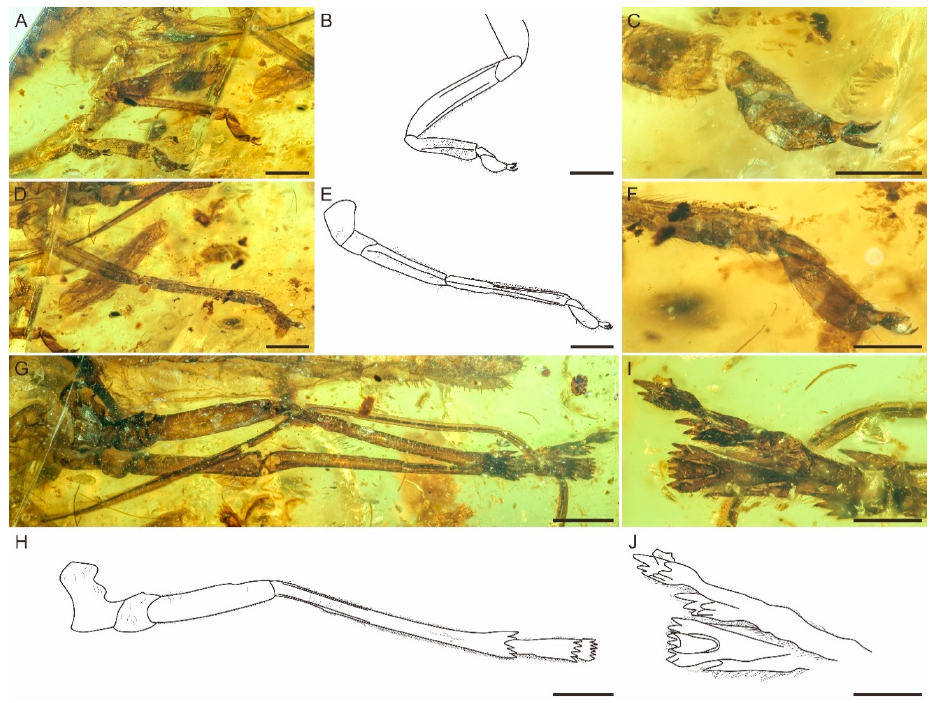
Figure 3. Detailed photographs and line drawing of legs of Spinonympha shcherbakovi gen. et sp. nov. ( A ) Left foreleg in left lateral view. ( B ) Line drawing of left foreleg in left lateral view. ( C ) Protarsus. ( D ) Left midleg in left lateral view. ( E ) Line drawing of left midleg in left lateral view. ( F ) Mesotarsus. ( G ) Hindleg in left lateral view. ( H ) Line drawing of left hindleg in left lateral view. ( I ) Mesotarsus. ( J ) Line drawing of mesotarsus. Scale bars for ( A , B , D , E , G , H ) = 1.0 mm; ( C , F , I , J ) = 0.5 mm.